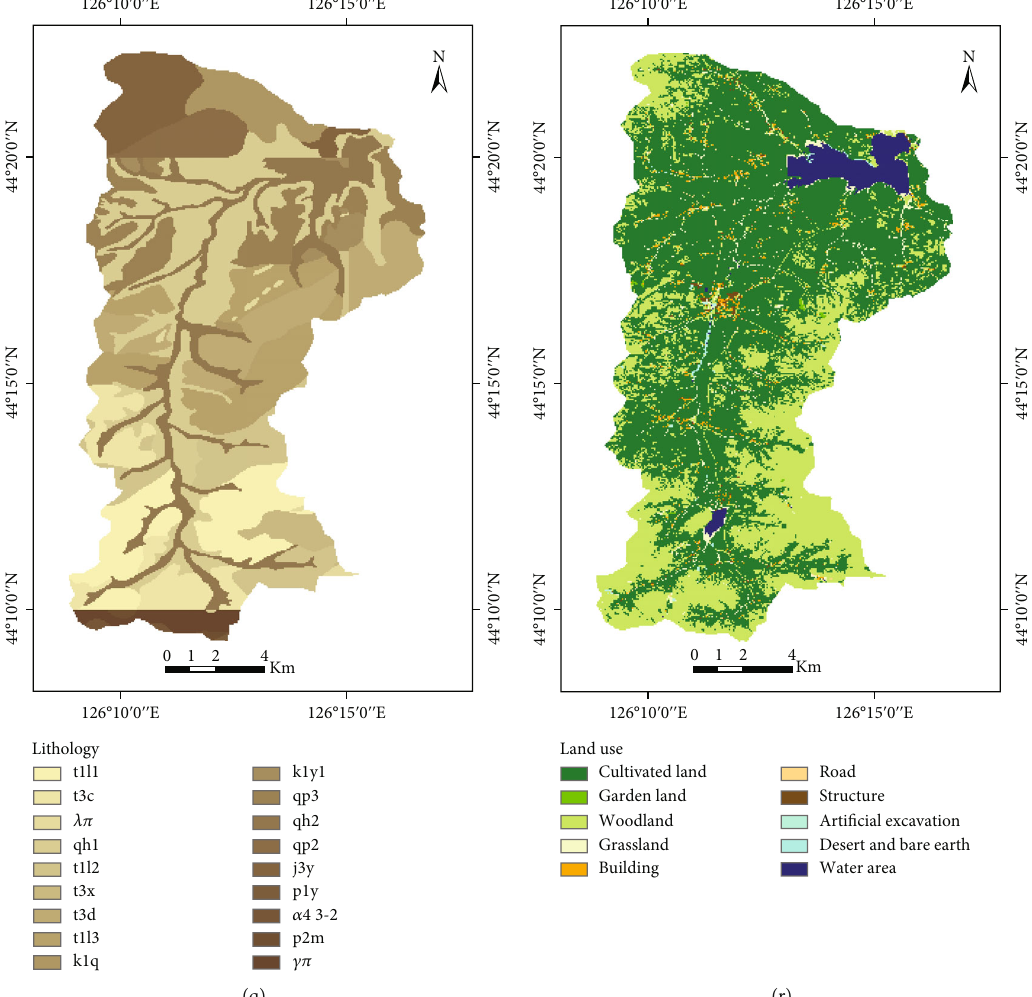
Figure 2: In fl uencing factors on gully erosion ((a) rainfall erosivity, (b) elevation, (c) slope shape, (d) slope aspect, (e) slope position, (f) slope degree, (g) slope length, (h) distance from residential area, (i) distance from the river, (j) distance from the road, (k) plane curvature, (l) sectional curvature, (m) catchment area, (n) topographic wetness index, (o) soil type, (p) soil erodibility, (q) lithology, and (r) land